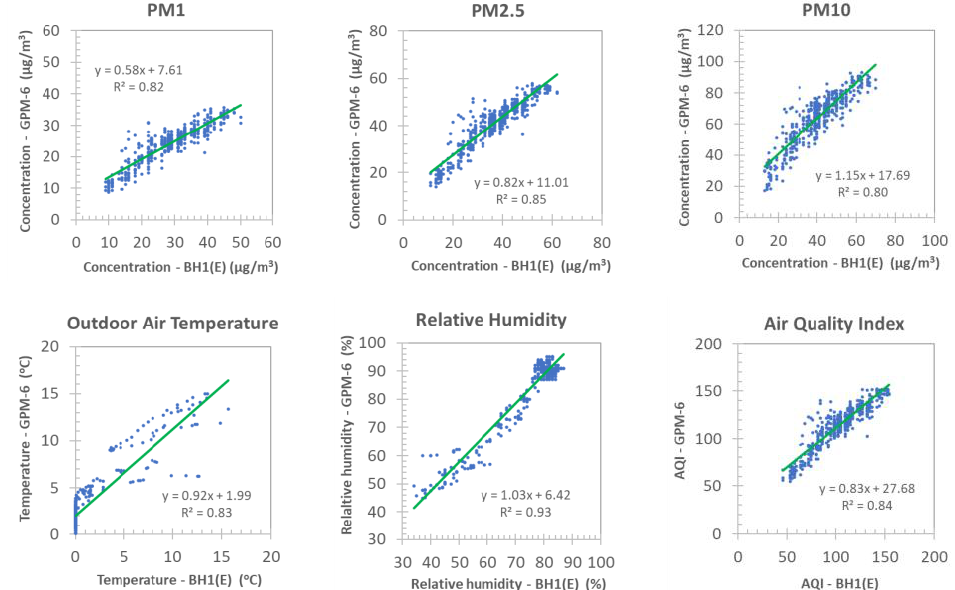
Figure 8. Correlation between the data series of the GPM and BH1 sensors for outdoor air at the suburban site, recorded between 6 and 12 December 2021 (sampling rate: 1–5 min, n = 1170).